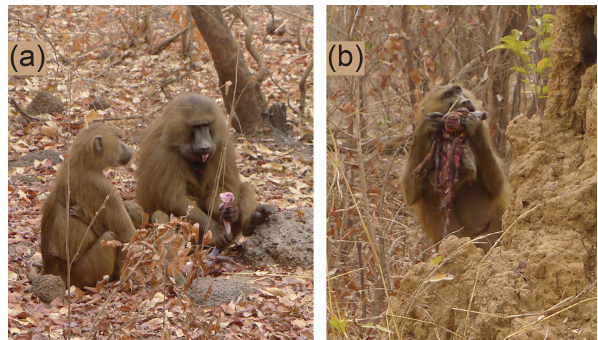
Figure 2. (a) Male–female meat sharing and (b) female eating